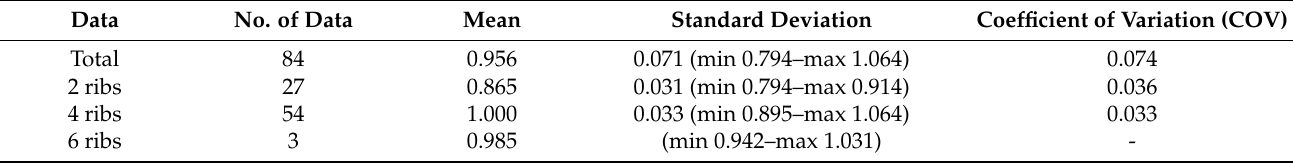
Figure 5. Comparison of experimental and calculated data (Equation (3)): ( a ) 2 ribs, ( b ) 4 ribs, ( c ) 6 ribs, ( d ) total data. As summarized in Tables 16 and 17, the new shear resistance formula (Equation (3)) provides better estimations than the current formula (Equation (1)). The estimations range from 0.794 to 1.064, which is better than the current estimation ranging from 0.777 to 1.189 in Table 6. The COV is reduced from 0.109 (current formula) to 0.074 (proposed formula). Especially for 4-rib specimens, the estimation errors range from 0.895 to 1.064 with a mean of 1.000 (COV of 0.033) in the proposed formula, whereas the current formula ranges from 0.862 to 1.189 with a mean of 1.034 (COV of 0.067). All the ultimate shear resistances in Figure 5 and Table 17 are the resistances of one-pair sets of n-rib specimens. The proposed formula generally overestimates the resistances for the specimens with 2 ribs. However, the estimation errors are improved from 0.777–0.902 with mean of 0.844 to 0.794–0.914 with mean of 0.865. Table 16. Statistical characteristics of the proposed resistance formula (Experimental result/Estimation by Equation (3)). Data No. of Data - Table 17. Comparison of experimental resistance and estimated results (Equation (3)). Test No. Exp.